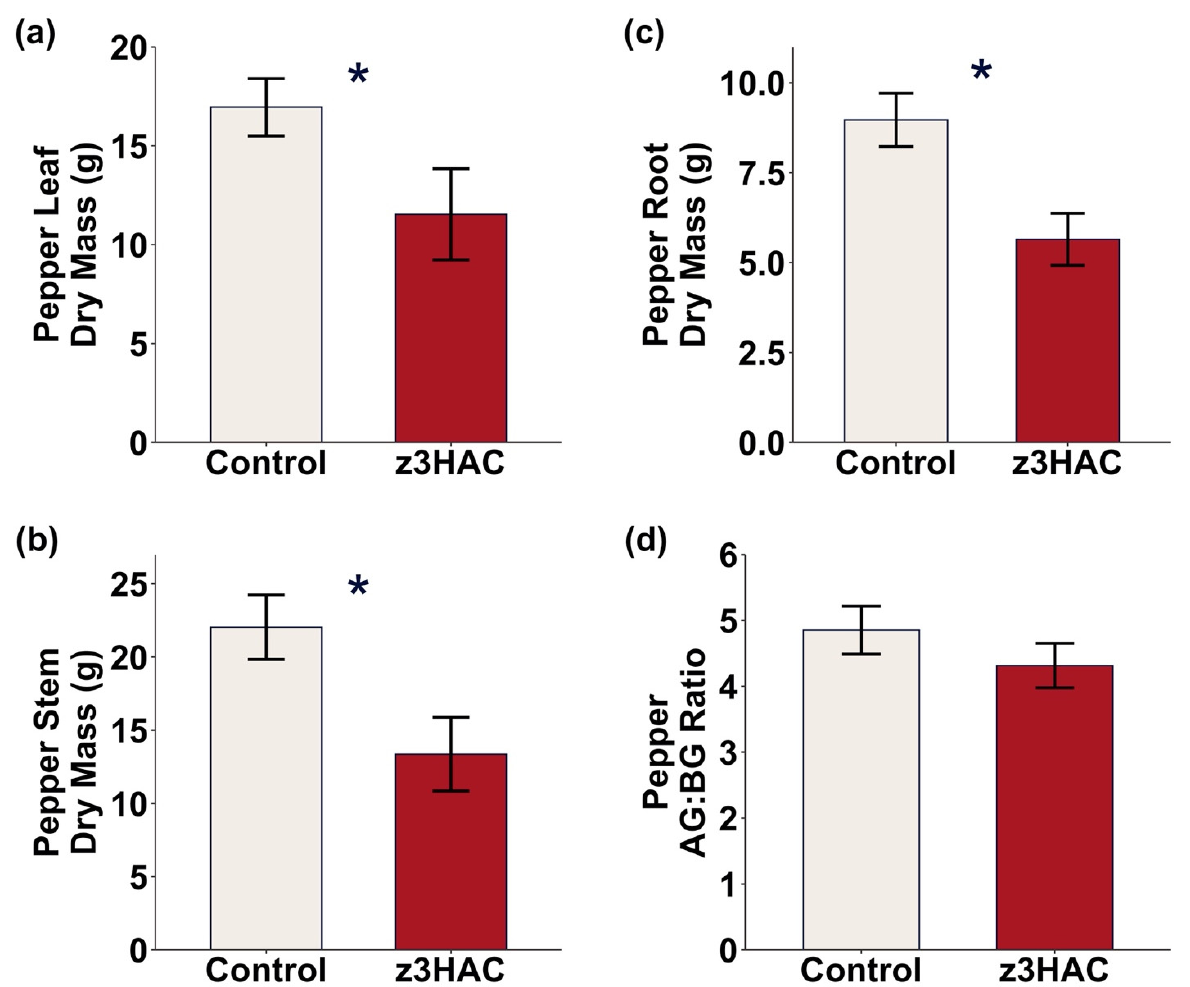
Figure 3. Biomass measurements of field-grown Capsicum annuum (pepper) plants. ( a ) Leaf, ( b ) stem, ( c ) root biomass, and ( d ) the aboveground:belowground biomass ratio in C. annuum plants were determined at the end of the field season following destructive harvest. Bars represent the means +/ − S.E.M. Asterisks (*) represent p < 0.05. See Supplemental Table S2 for statistics.